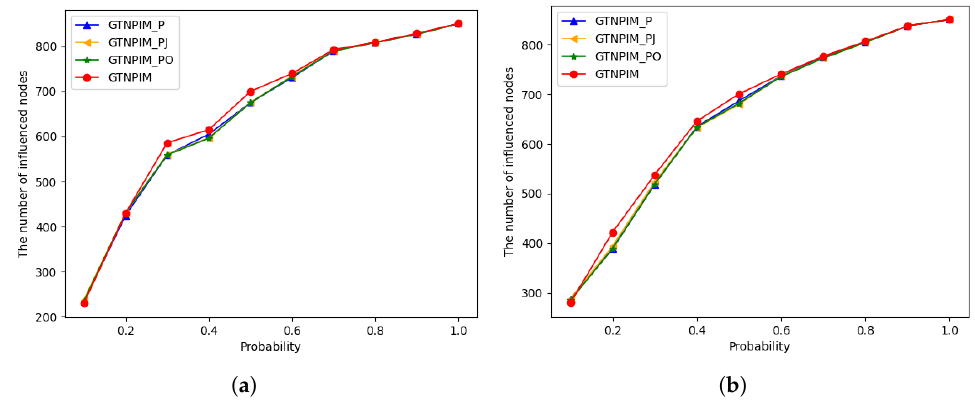
Figure 7. The spread of influence with different spreading probabilities on homogeneous and heterogeneous networks. ( a ) Biological computing data, ( b ) Membrane computing data.